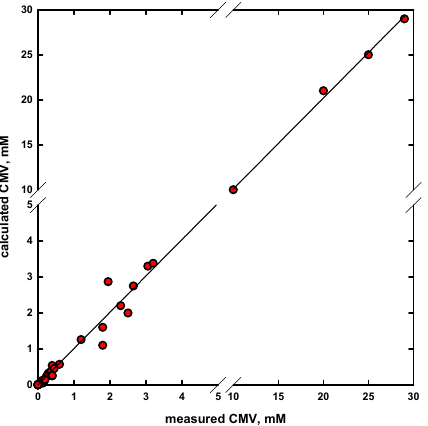
Figure 10. Comparison of measured and predicted values of CMV for investigated frothers (determination coefficient R 2 = 0.9985, standard error of estimate σ est = 0.2592).